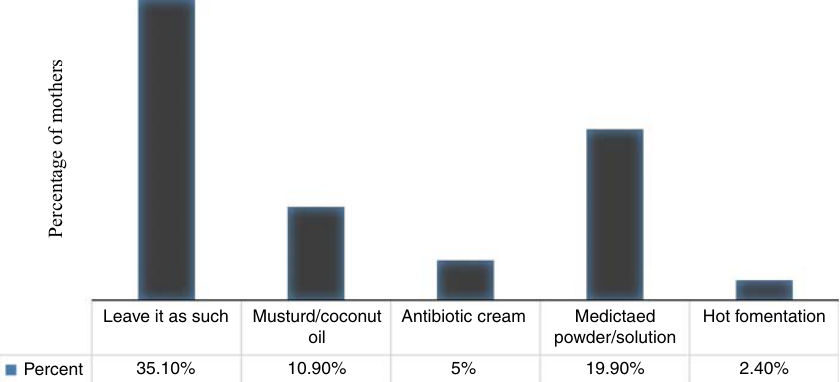
Figure 2. Knowledge regarding care of umbilical cord